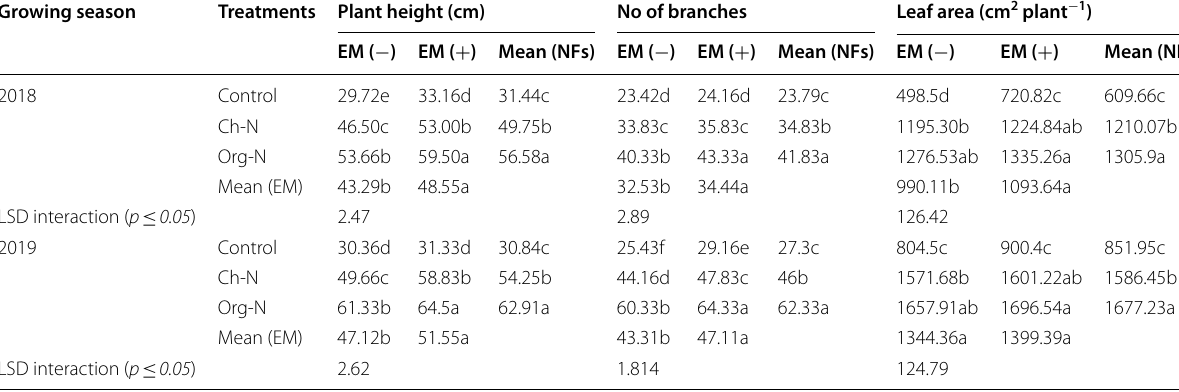
The values shown in table are means of two cuttings having four replicates. EM Effective microorganisms (biofertilizer), C h-N Chemical-N form, Org-N Organic-N form, Means followed by the same letters are non-significantly different ( p 0.05 ) ≤ Table 4 Effect of nitrogenous fertilizers and effective microorganisms on plant fresh weight, plant dry weight and dry leaves yield of Stevia rebaudiana during two growing seasons